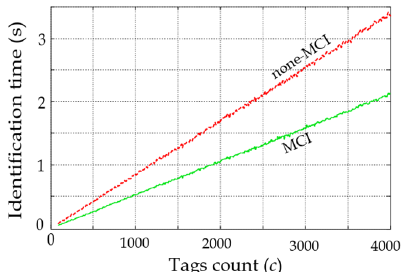
Figure 11. Average identification time for different tag population in the standardized Q-Algorithm.